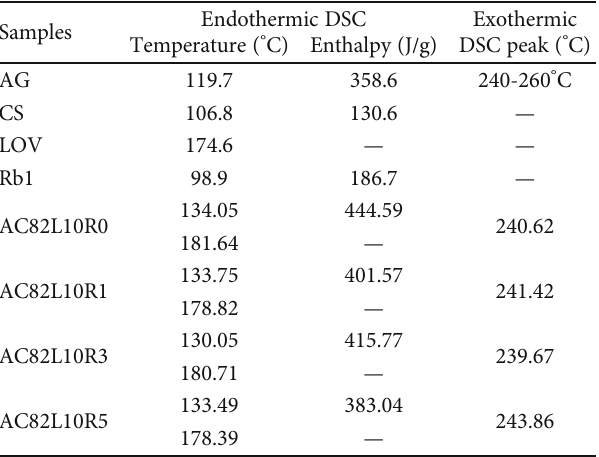
Figure 2: FESEM images of AC82L10R x composite fi lms. Table 2: DSC parameters obtained from DSC diagrams of AG, CS, LOV, Rb1, and AC82L10R x composite fi